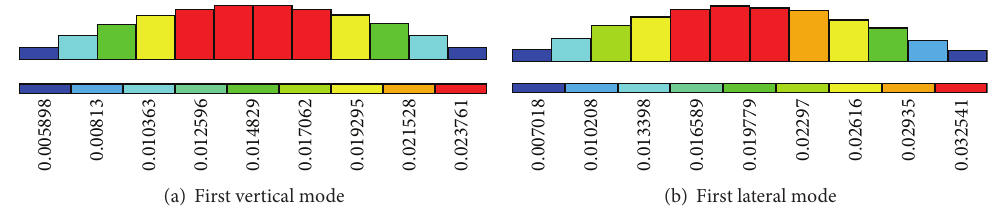
Figure 21: Strain modes identified by FE simulation.